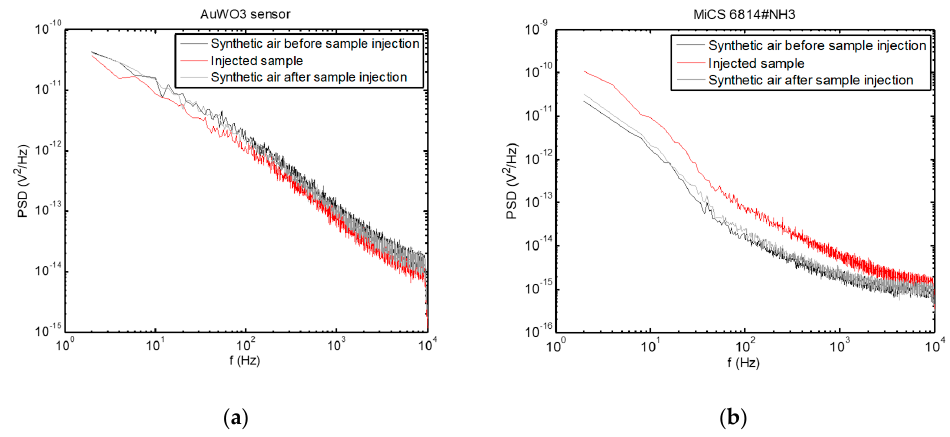
Figure 4. DC sensors responses in the presence of: ( a ) Breath sample of a patient with confirmed echinococcosis; ( b ) Breath sample of a control volunteer; ( c ) Room air. ( d ) to ( f ): Zoom of the AuWO 3 sensor responses presented in Figure 4( a ) to 4( c ), respectively. AE: Alveolar echinococcosis; Not AE: Control.